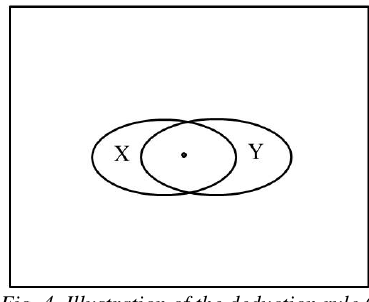
Fig. 4. Illustration of the deduction rule